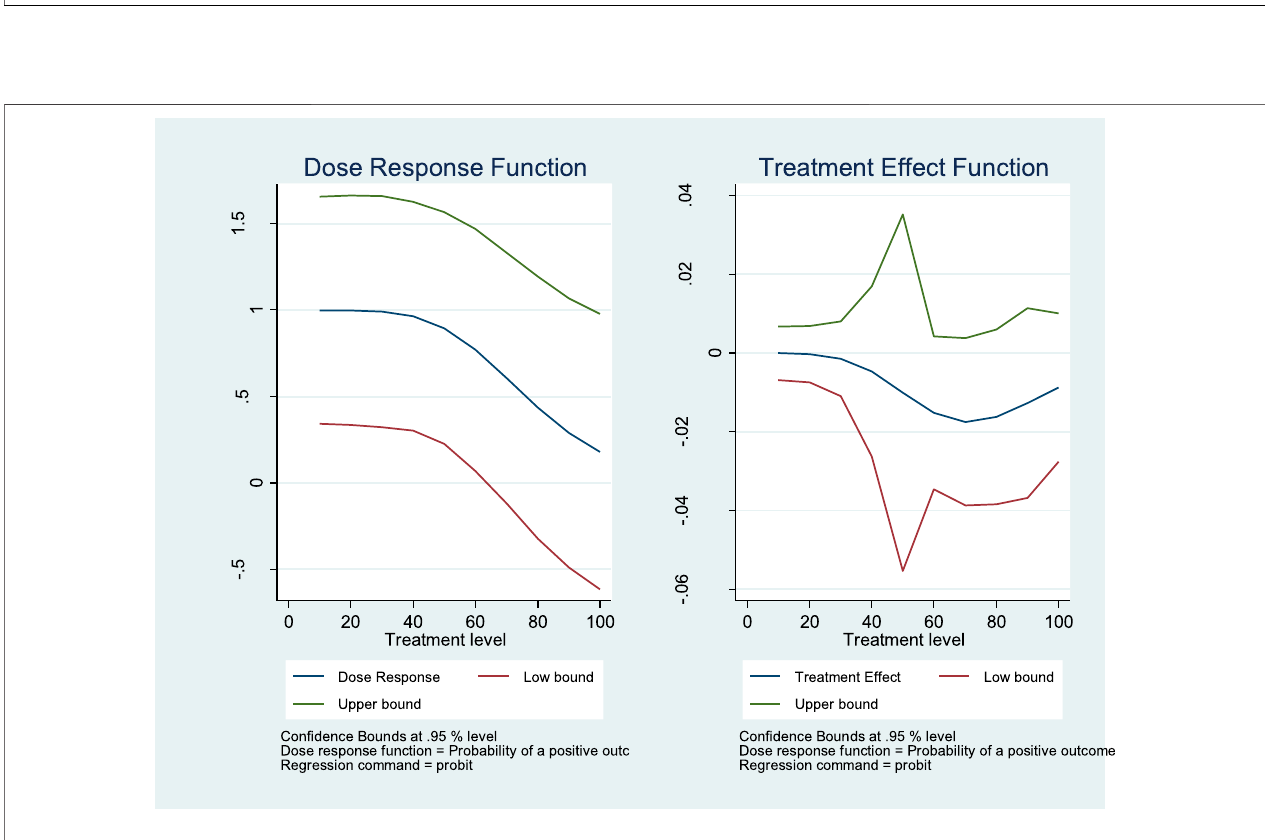
FIGURE 4 | Does-response and treatment effect of EV purchase probability without type.